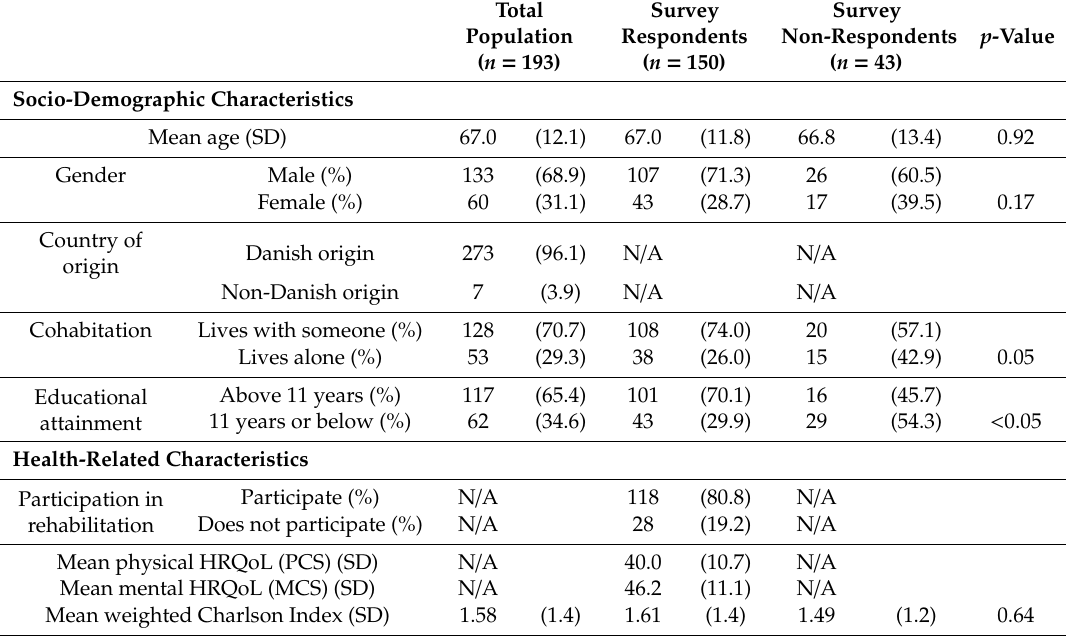
Table 2. Population characteristics by survey participation in the Heart Skills Survey in Randers Municipal Rehabilitation Unit